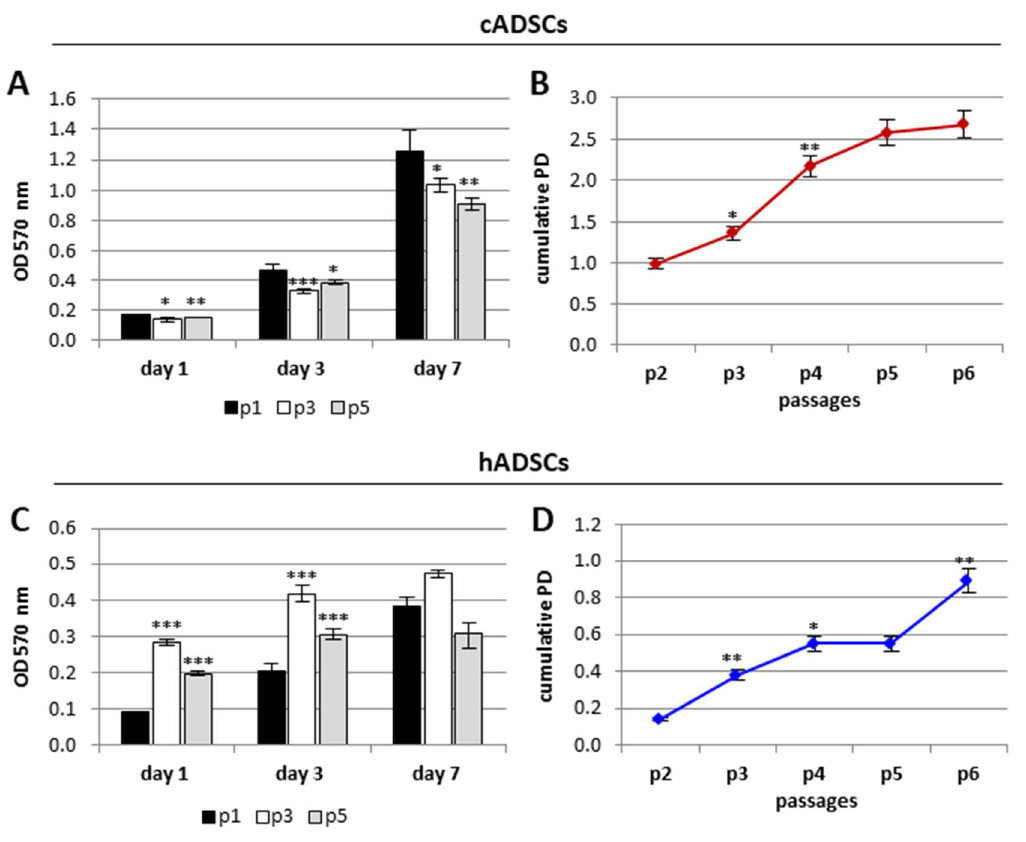
Figure 3. Proliferation rate of cADSCs and hADSCs. ( A , C ) MTT assay of cADSCs and hADSCs, respectively, at p1, p3, and p5 at days 1, 3, and 7 post seeding. Data are expressed as mean ± SD ( n = 3). * p < 0.05, ** p < 0.01, *** p < 0.001 indicate statistically significant difference compared to cells at p1. ( B , D ) Cumulative Population Doubling (PD) of cADSCs and hADSCs, respectively, from p2 to p6. PD is measured at each passage. Data are expressed as mean ± SD ( n = 3). * p < 0.05, ** p < 0.01, *** p < 0.001 indicate statistically significant difference compared to cells at the previous